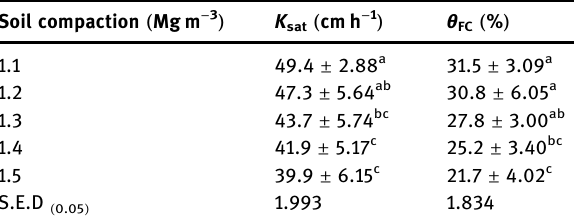
Table 2: Saturated hydraulic conductivity and fi eld capacity as in fl uenced by soil compaction